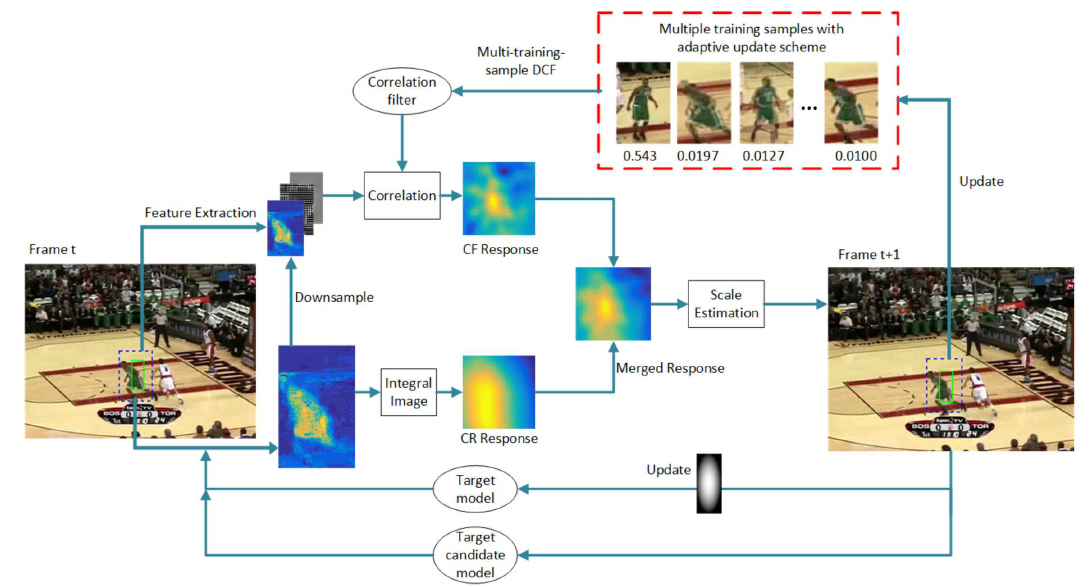
Figure 2. The overall sketch of the proposed CRCF_ATU